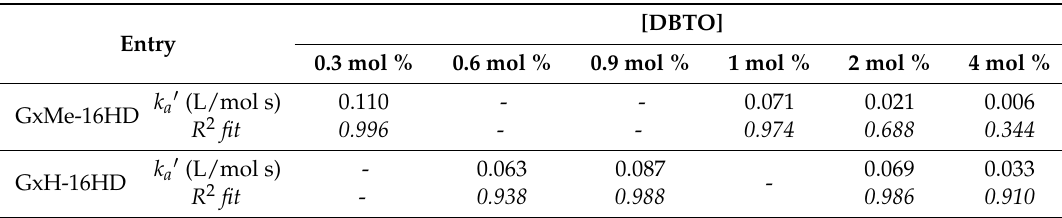
Table 1. Overall kinetic constants determined for a second order fitting of the transesterification reactions of GxMe, respectively, GxH diester with 1,6-hexanediol and the R squared values for the linear fit.